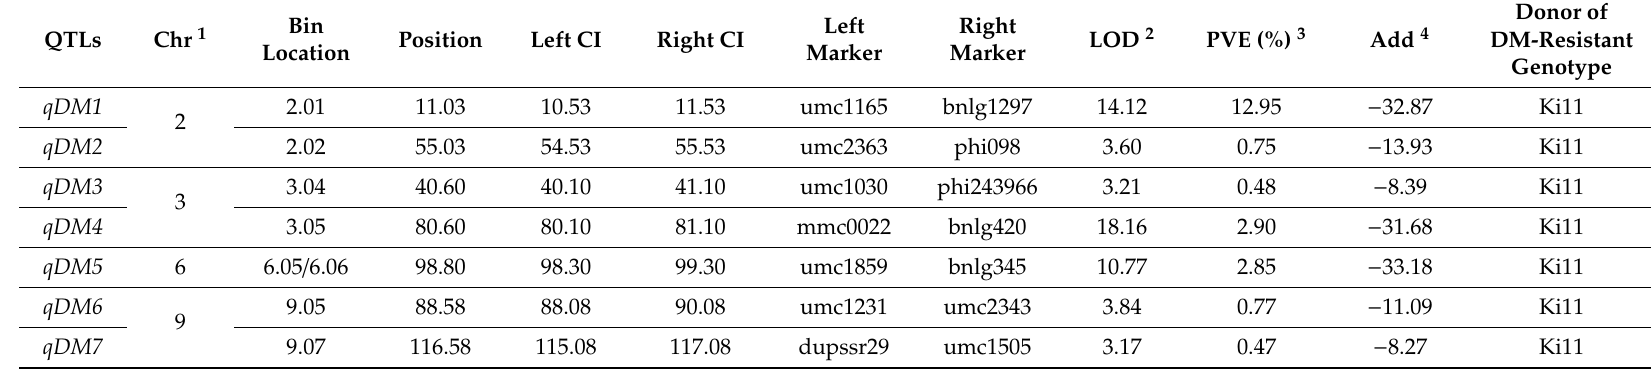
Table 3. Quantitative trait loci (QTLs) for P. sorghi , P. maydis , and S. macrospora resistance for the F 7 families derived from B73 (susceptible) × Ki11 (resistant). Bin QTLs Chr 1 Position Left CI Right CI Location